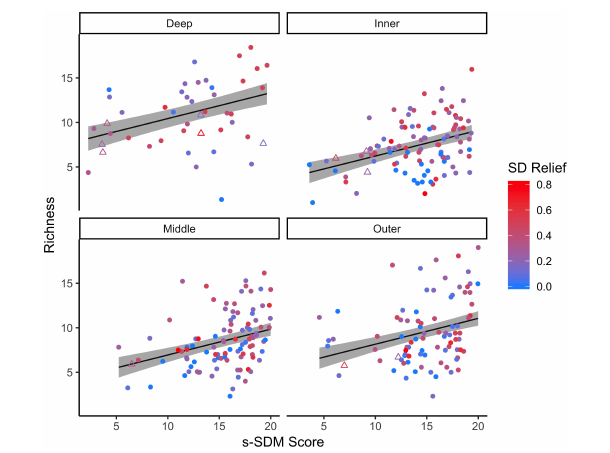
FIGURE 3 | Linear relationship between predicted s-SDM score and observed bootstrap species richness for the 21 focal species. The linear regression was completed for the 21 focal species on all natural reef sites (circles) at four depth zones: inner ( ∼ 5 m), middle ( ∼ 10 m), outer ( ∼ 15 m) and deep ( ∼ 25 m). Established manmade reef sites (triangles) for reference. Colors indicate standard deviation (SD) of relief at each reef site, from low (blue) to high (red) fine scale habitat heterogeneity. 95% confidence intervals of the regression lines are shown in